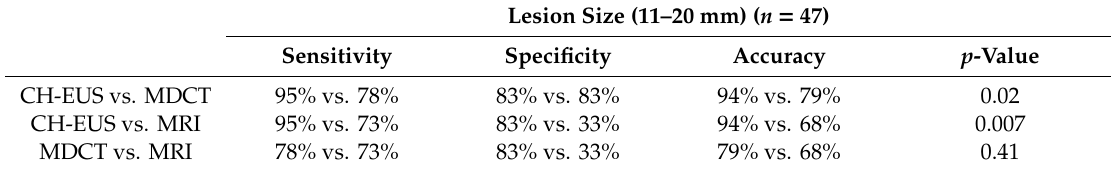
Table 2. Diagnostic ability of three modalities (CH-EUS, MDCT, MRI) for pancreatic lesion measuring 11–20 mm.